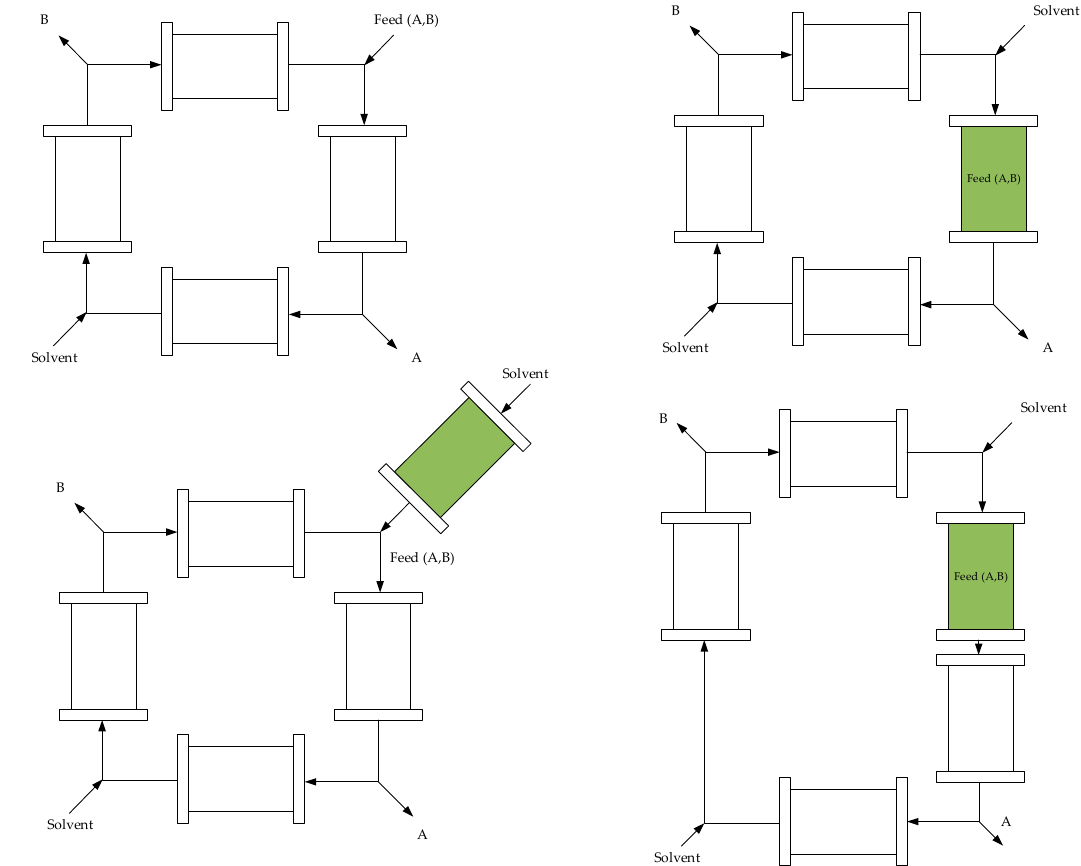
Figure 12. Potential configurations of Phyto ‐ SMBC, upper left: conventional SMBC, all other flow charts depict potential process options of Phyto ‐ SMBC processes, plant raw material in green with component faction A strong binding in chromatography as extract and component faction B as weaker binding raffinate.